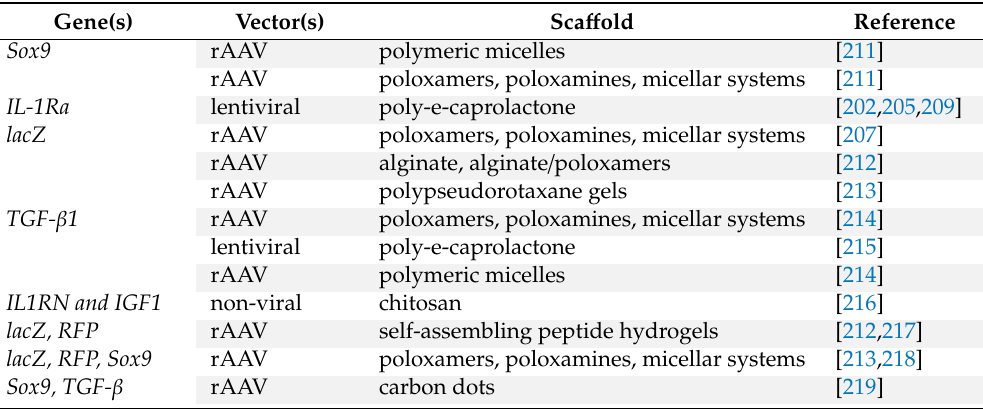
Table 3. Sca ff old-based gene therapy approaches in cartilage